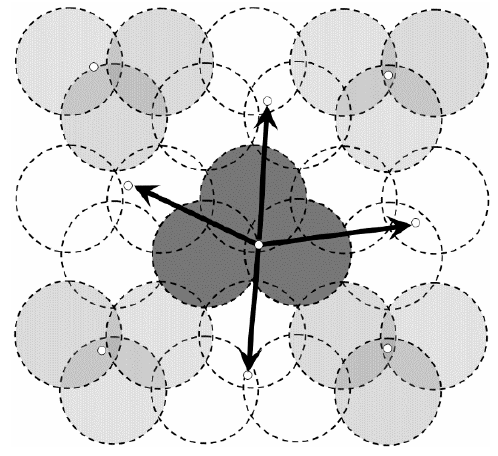
Figure 13. The next available TPs for selection.